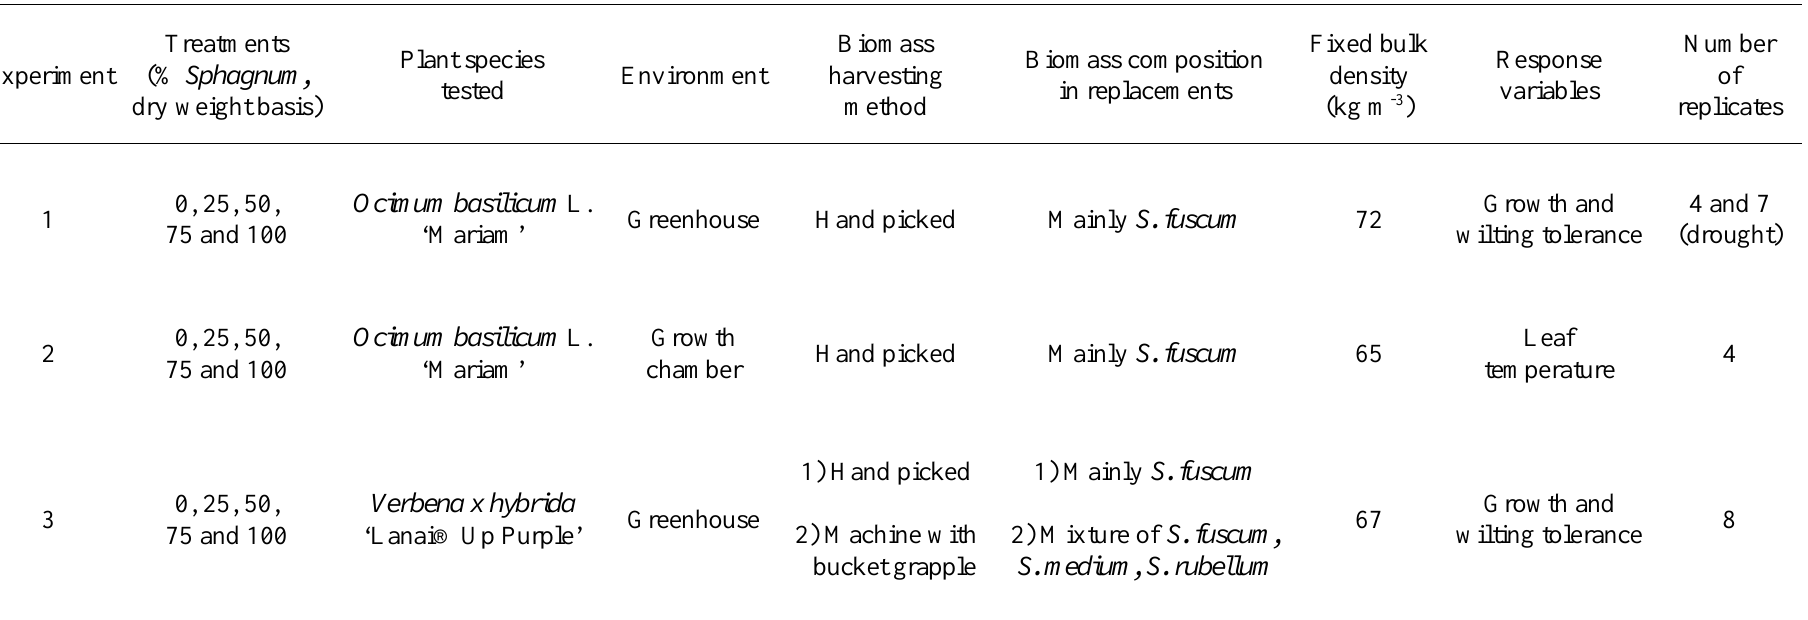
Table 3. Summary of the three experiments with plants.